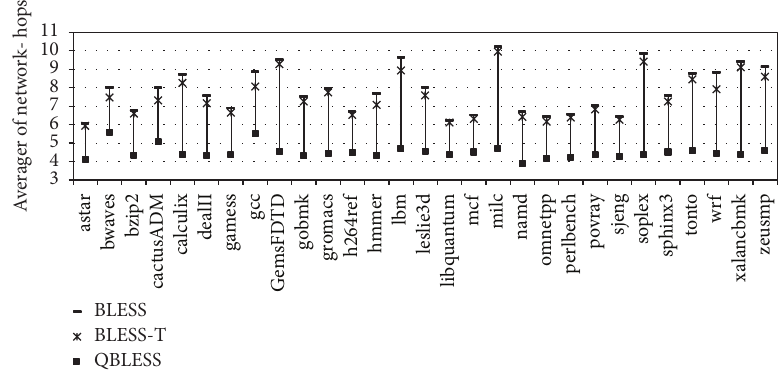
Figure 9: Average network-hops of high-priority